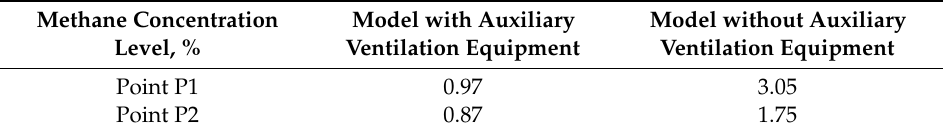
Table 5. The comparison of the methane concentration values determined on the basis of model-based tests, for systems with and without AVE in the measurement points (P1 and P2).